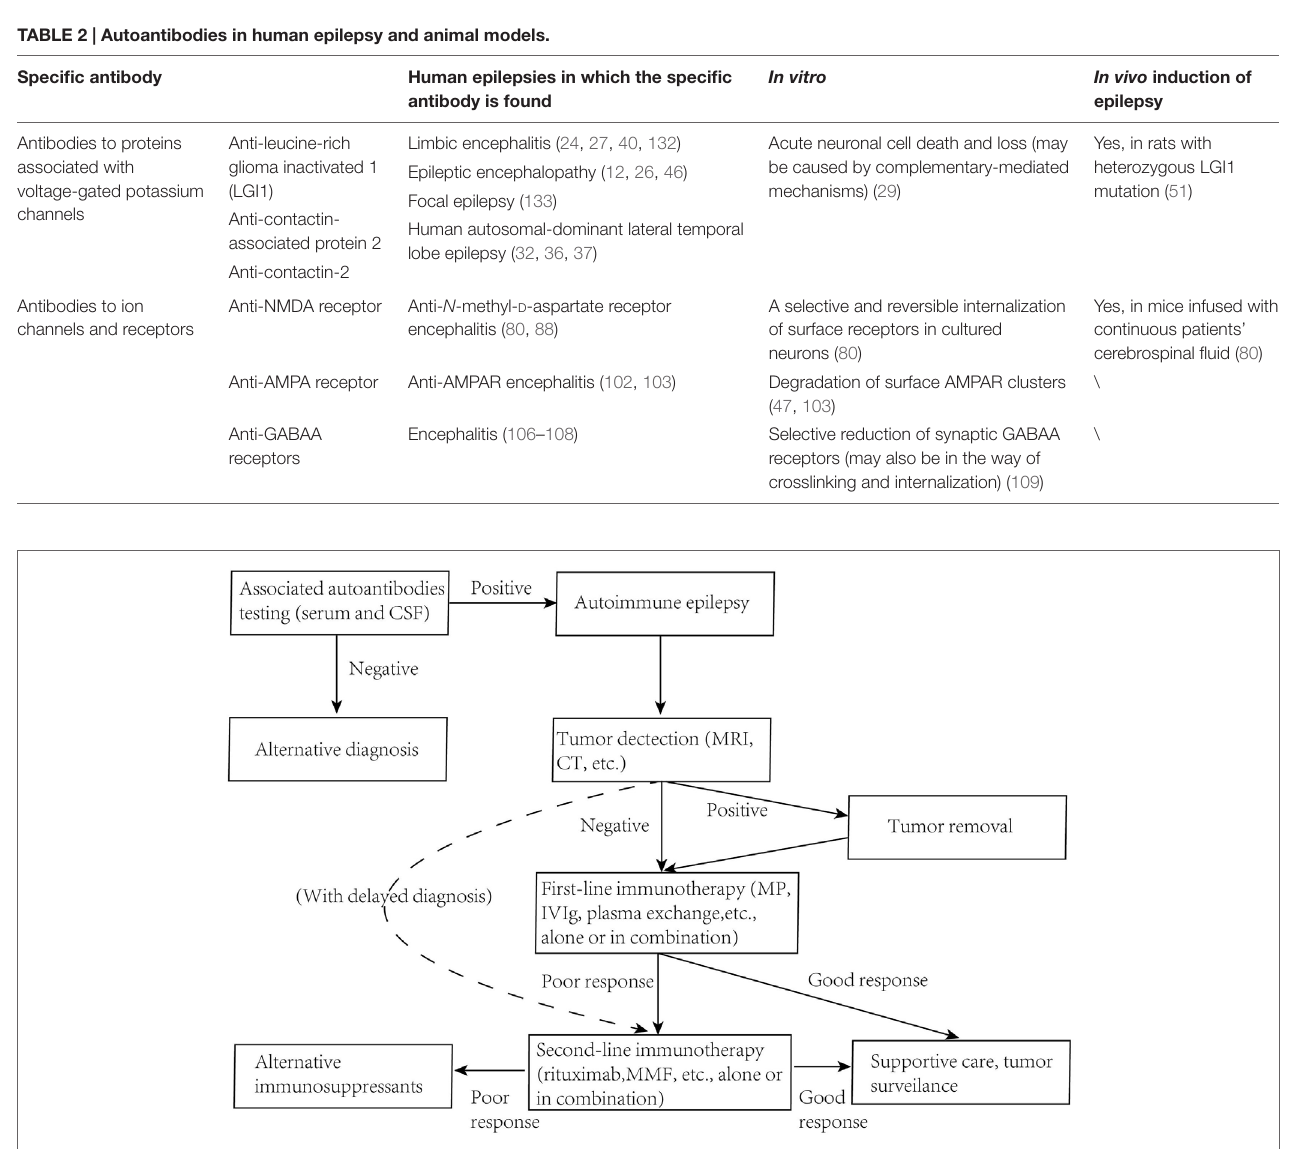
FiGURe 4 | Guidelines for immunotherapy of autoimmune epilepsy diseases . MRI, magnetic resonance imaging; MP, methylprednisolone; MMF, mycophenolate